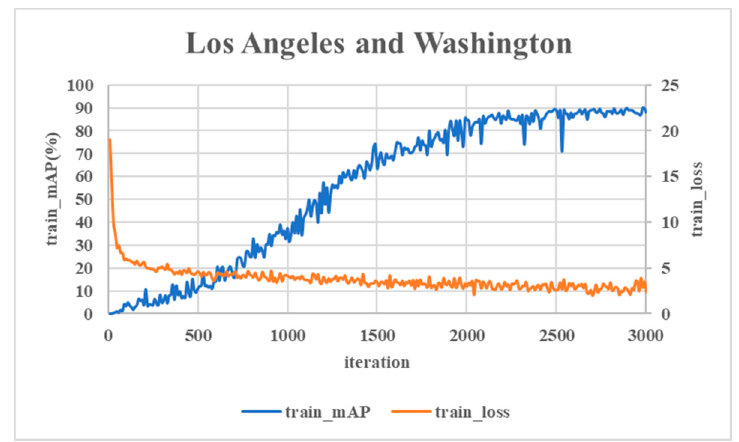
Figure 17. mAP and loss variation of the Los Angeles and Washington training data sets with general deep learning.